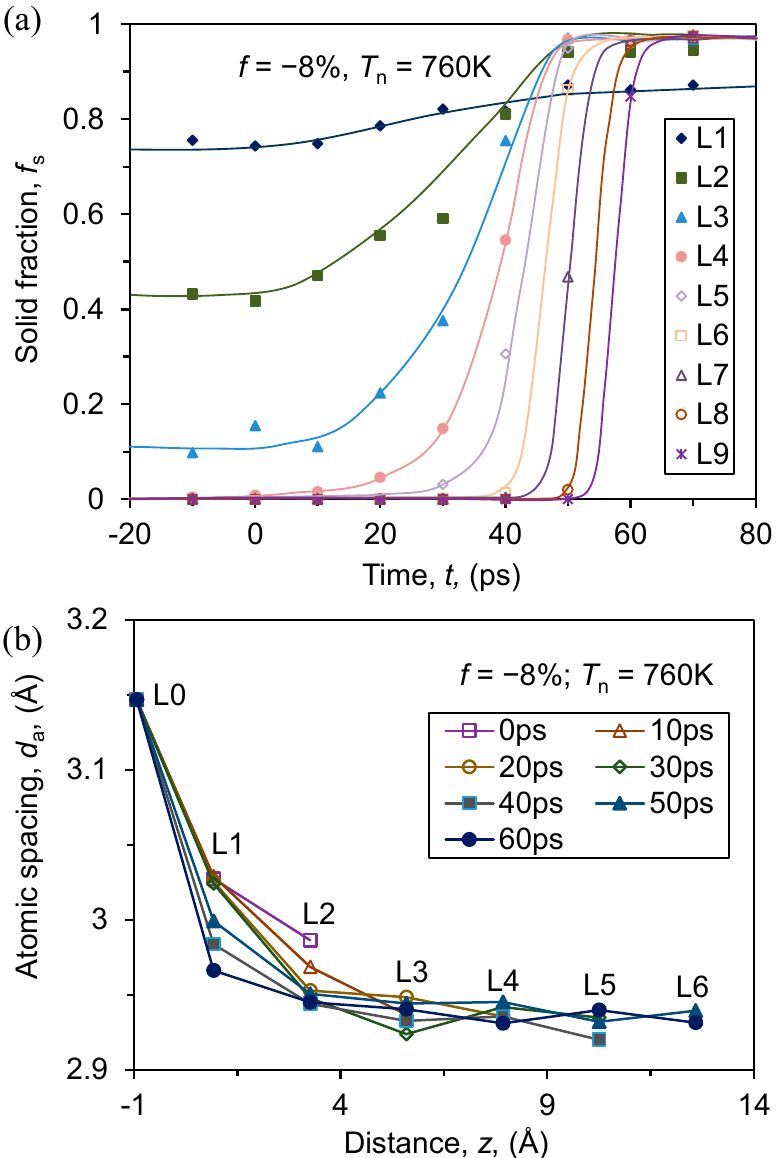
Figure 5. ( a ) Fraction of the solid atoms, f s , and ( b ) average atomic spacing, d a , of the ordered regions in the individual layer at the interface as a function of z and t during the simulation of the system with f = − 8% at T n = 760 K.